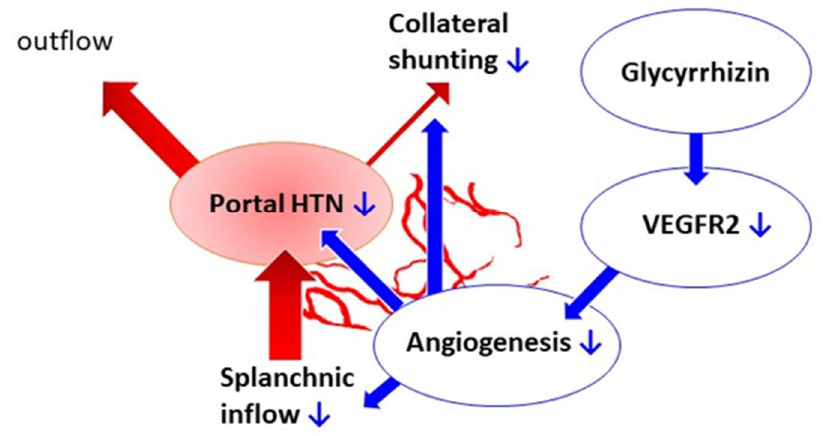
Figure 9. Effects of glycyrrhizin on portal hypertension-related derangements. Glycyrrhizin sup- pressed mesenteric angiogenesis through VEGFR2 downregulation. The splanchnic blood inflow and collateral shunting thus decreased. The hepatic system was unaffected by glycyrrhizin. The net effect of glycyrrhizin is the amelioration of portal hypertension.